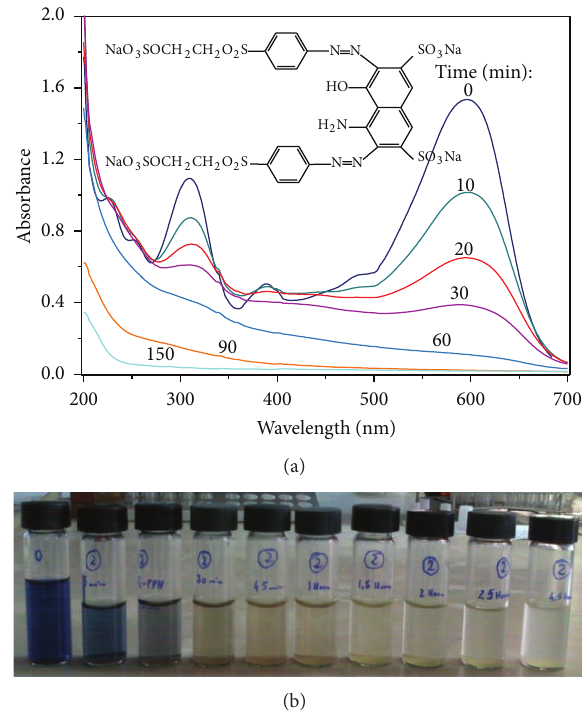
Figure 4: RB5 photodegradation with Fe-PPH: (a) UV-Vis spectra evolution (inset the chemical structure of RB5). (b) Dye colour evolution. [RB5] = 50 mgL −1 ; [PPH] = 1gL −1 ; [ H 2 O 2 ] = 2.0 × 10 −3 molL −1